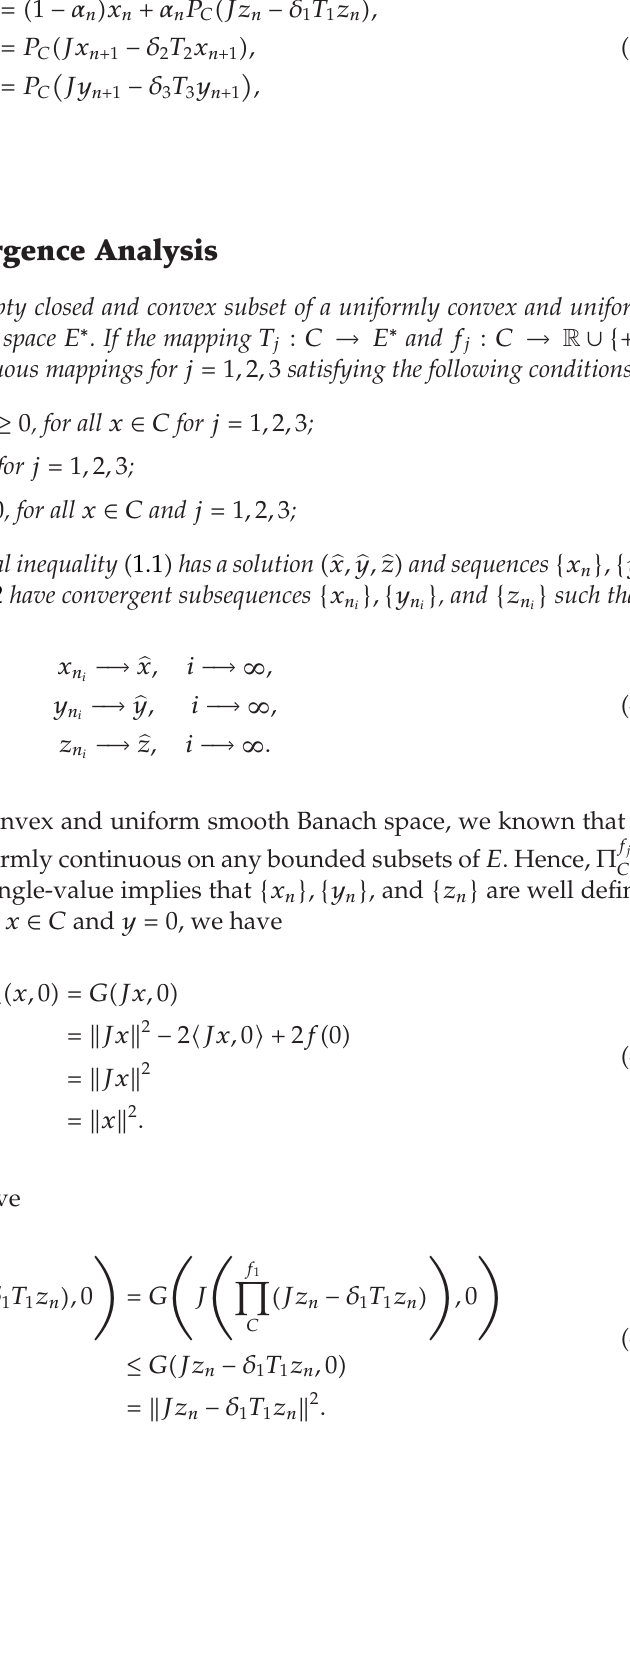
Algorithm 3.5. For an initial point x 0 , z 0 ∈ C , define the sequences { x n } , { y n } , and { z n } as